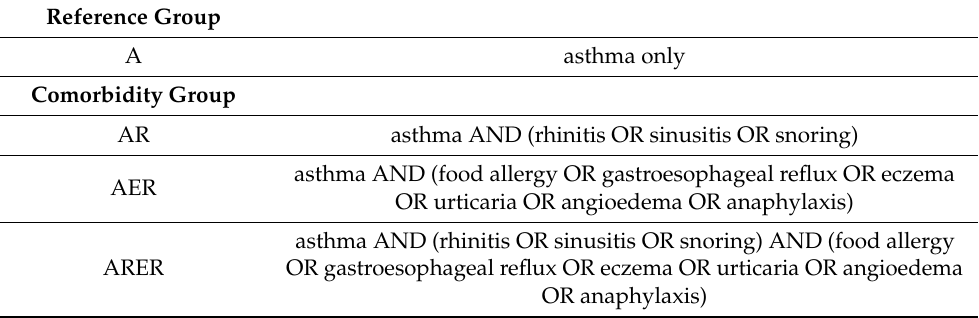
Table 1. Definition of the comorbidity groups. A: asthma only. AR: asthma with respiratory comor- bidities. AER: asthma with extra-respiratory comorbidities. ARER: asthma with both respiratory and extra-respiratory